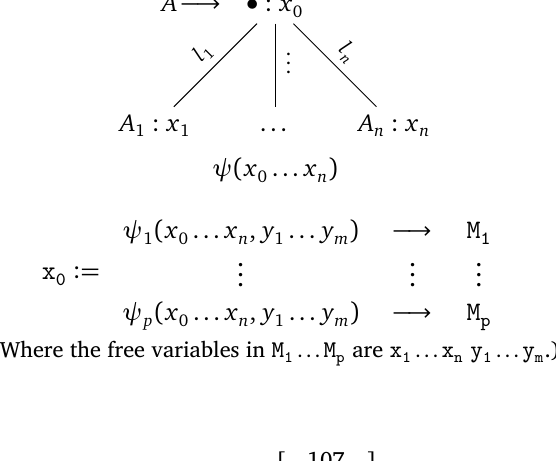
Figure 6: Constrained production with its associated linearization